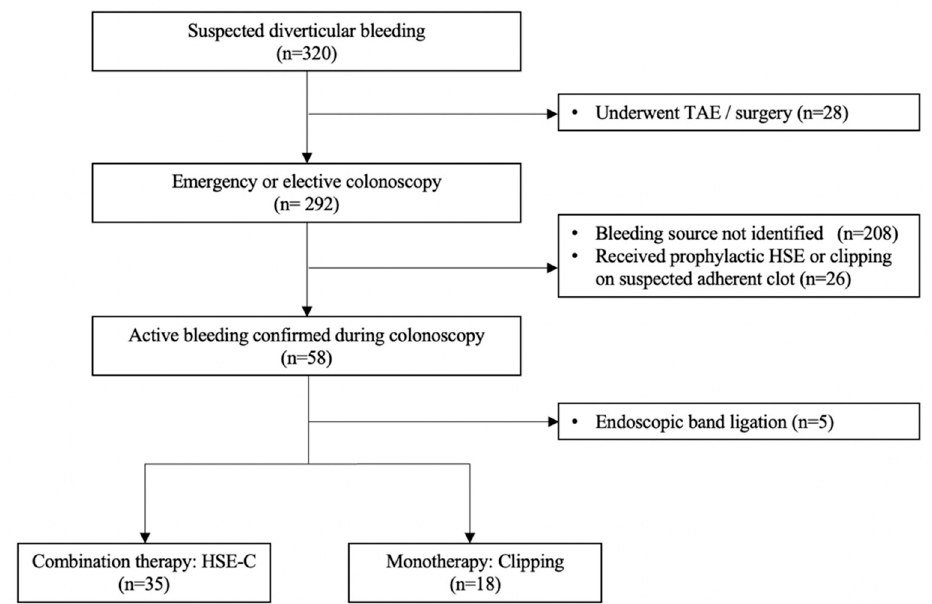
Figure 4. CONSORT diagram of the study. Table 1. Baseline characteristics and clinical findings of patients assigned HSE-C or clipping for active diverticular